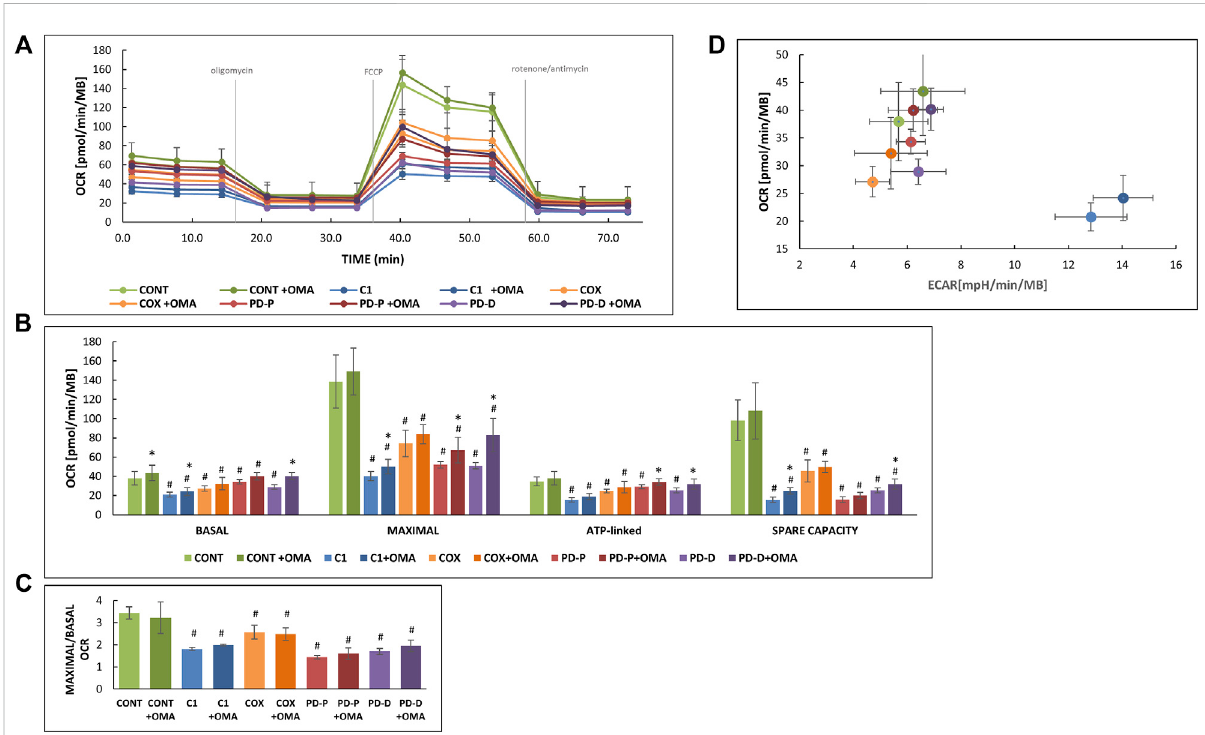
FIGURE 2 Effectofomaveloxoloneonrespiration.Anequalamountofcontrolcells(CONT)withmitochondrialCI(C1)orCOX(COX)de fi ciencyorPDwith mutated PRKN (PD-P) or mutatedDJ-1 (PD-D) was seeded on XF96-well, cultivated in the presence or absence of 50 nM omaveloxolone (OMA) for 72 h GLU medium subsequently oxygen consumption (OCR) and extracellular acidi fi cation rates (ECAR) was measured in glucose-containing XF seahorsemedium inanXFExtracellular 96-wellFluxAnalyzer andnormalizedtocellcontent measuredbymethylene blue(MB). (A) Depictsthe OCR track with time. (B) Calculated basal, maximal,ATP-linkedOCR and sparecapacities. (C) Calculated respiratorycontrol ratios (MAXIMAL/BASAL OCR). Results are presented as mean ± SD relative to controls ( n = 2). # p < 0.05 compared to untreated control mean, * < 0.05 compared to the individual cell without additive. (D) An energy map was constructed by plotting basal OCR representing mitochondrial respiration versus ECAR (before the addition of oligomycin) representing glycolysis. Values toward the upper right quadrant represent more energetic